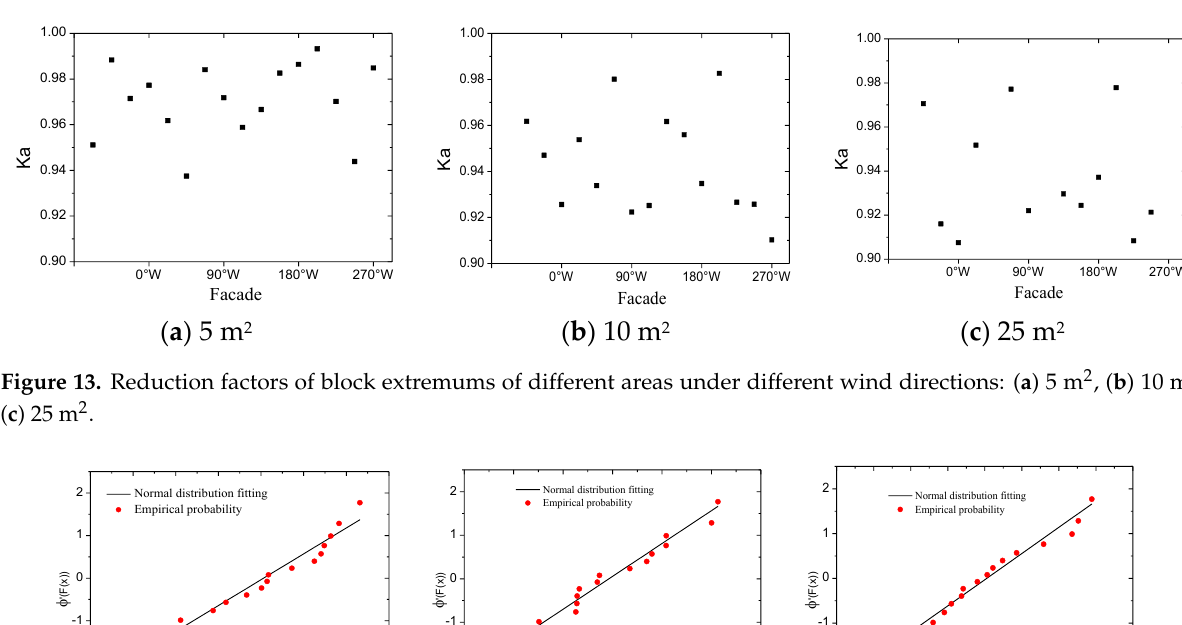
( d ) 270° Figure 12. The area reduction factors of different area sizes of each facade: ( a ) 0°, ( b ) 90°, ( c ) 180°, ( d ) 270°. The area reduction factors for the extreme pressure coefficient gradually decrease as the average-areas increase. The results from the comparison show that the reduction effect of the extreme wind pressure is smaller than the area reduction effect of the mean wind pressure. According to GB50009, the extreme wind effect will be underestimated by considering the area reduction of the design wind load of the cladding. Figure 13 shows the scatter diagram of the area reduction factor of the area-averaged extreme pressure coefficients with areas of 5 m 2 ,10 m 2 , and 25 m 2 under different wind direction angles. As can be seen from Figure 13, when the subordinate area is 5 m 2 ,10 m 2 , and 25 m 2 , the extreme wind pressure area reduction factor is in the range of 0.93 – 0.99, 0.88 – 0.98, and 0.85 – 0.97; the mean value of the area reduction factor is 0.97, 0.95, and 0.93;